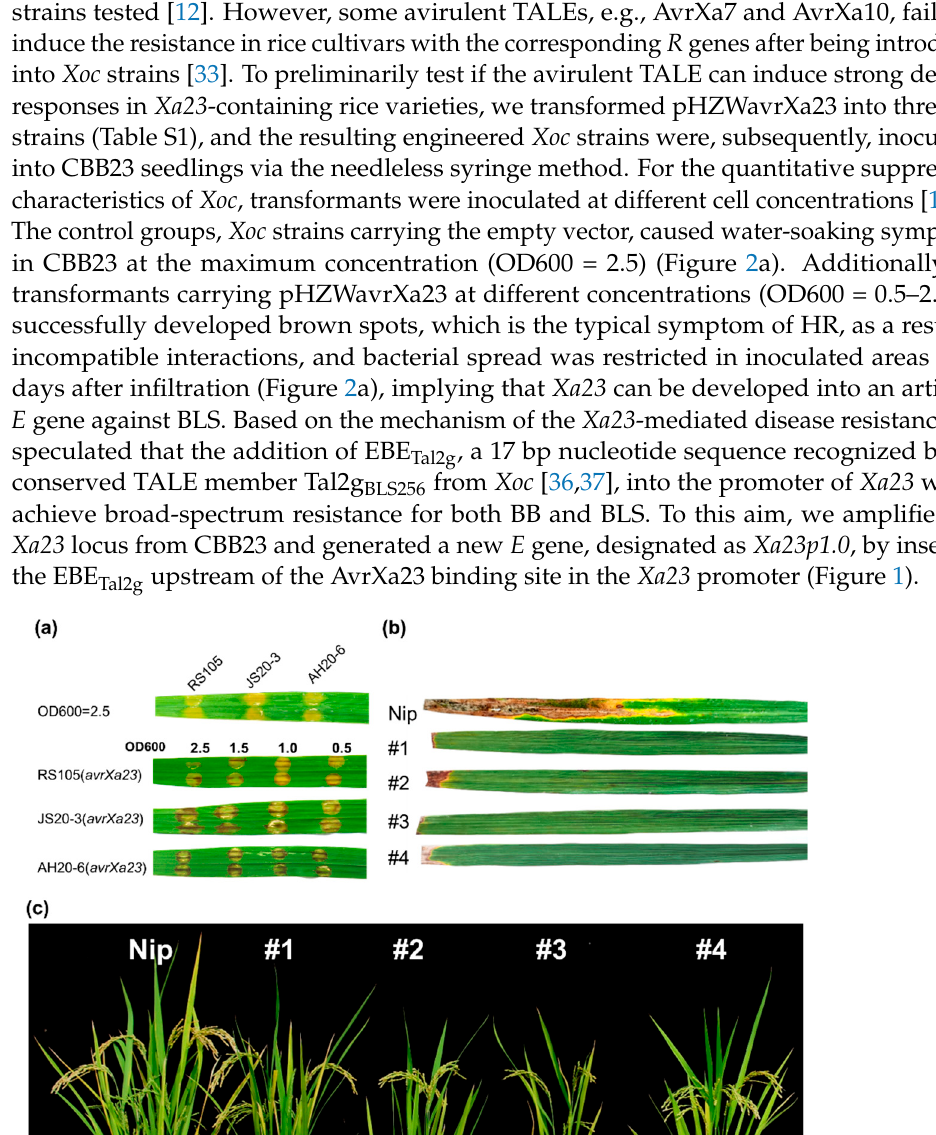
Figure 3. The basal levels of expression of Xa23p1.0 in transgenic rice plants. ( a ) The background expression of Xa23 in the T 2 plants of Xa23p1.0 transgenic rice. Relative expression levels were shown as a bar graph. ( b ) Disease reactions of Xa23p1.0 transgenic rice leaves to Xoc strain RS105, which was conducted by needleless syringe infiltration at OD600 = 1.0. 2.2. Xa23p1.0 Transgenic Rice Plants Exhibit Resistance to Xoc and Magnaporthe oryzae When the corresponding avirulence ( avr ) gene, avrXa23 , was expressed from a high- copy plasmid, we observed a strong HR in CBB23 (Figure 2a). However, we still needed to firstly investigate whether the Xa23 -mediated resistance induced by the endogenous avr gene on the chromosome was efficient for BLS. For that, the resistance suppression using Xoc was quantitative [16,33]. Here, RS105, the representative Xoc strain, was firstly